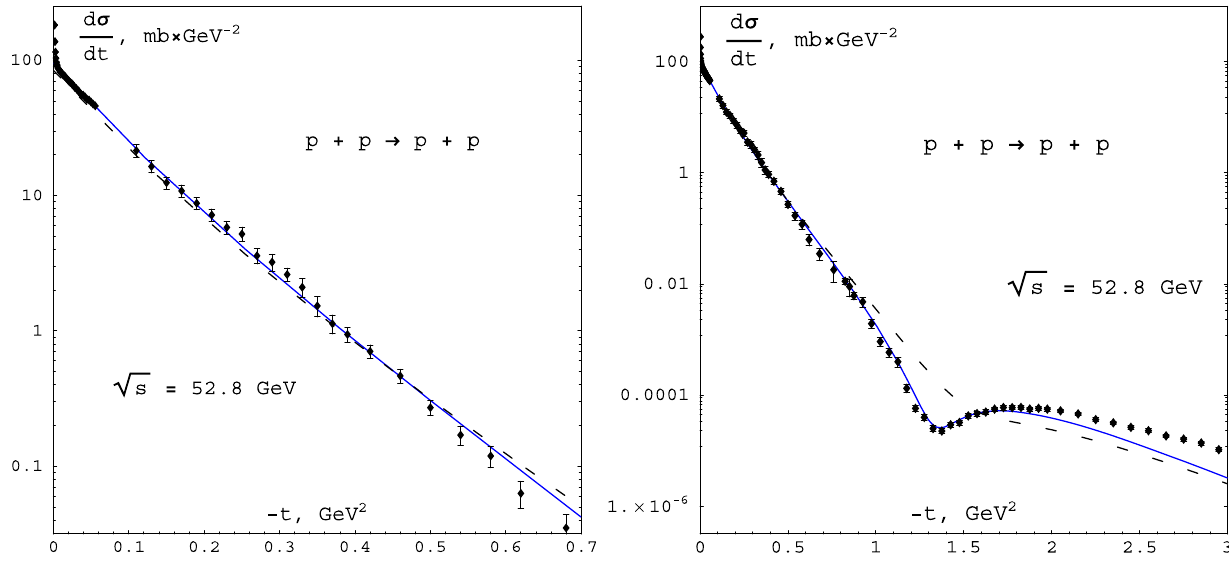
√ Fig. 8 The p p EDS angular distribution at s = 52 . 8 GeV. The solid lines correspond to the two-Reggeon eikonal model. The dashed lines are related to the one-Reggeon eikonal approximation wherein the FR exchange contribution to the eikonal is ignored